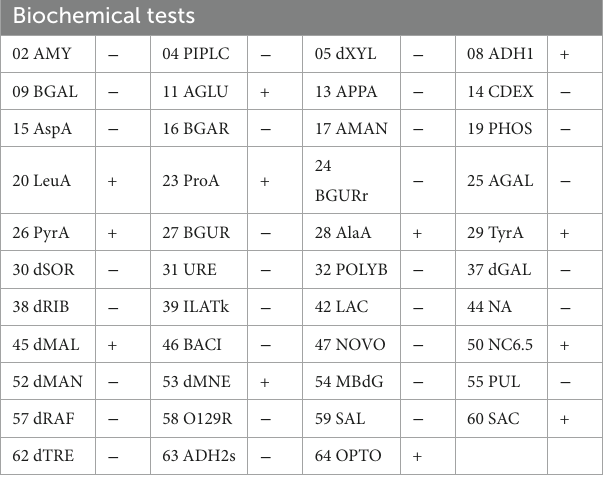
TABLE 1 Characterization of K. kristinae_LC by biochemical tests. Biochemical tests